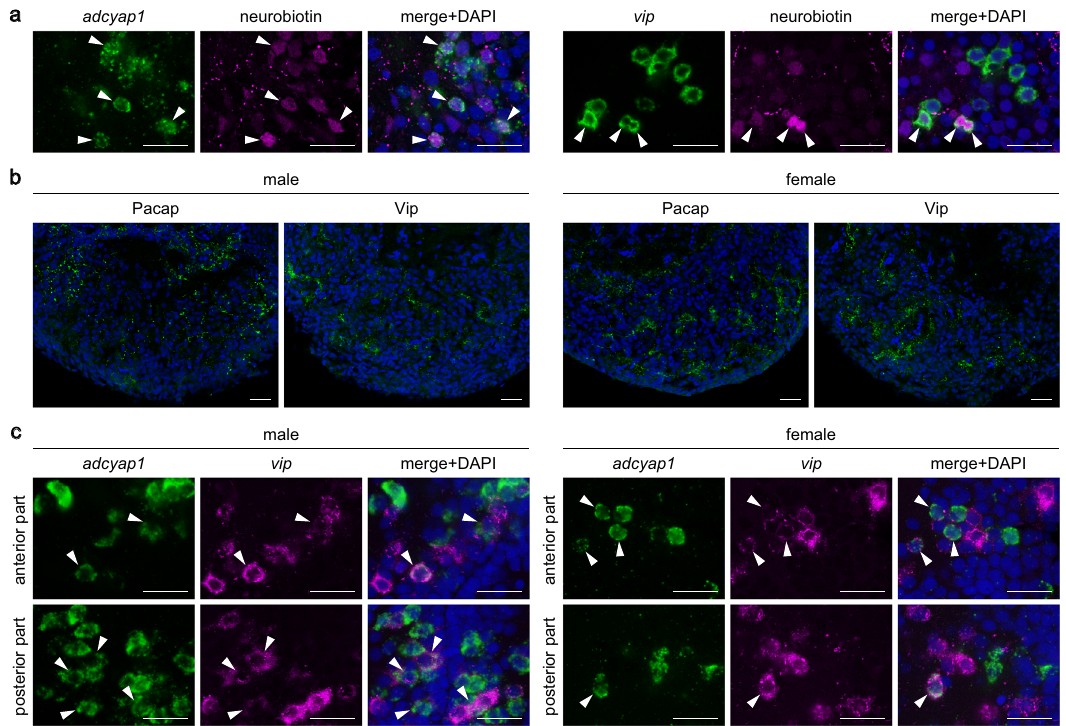
Fig. 6 adcyap1 and vip are expressed in the same population of POA neurons that project to the pituitary. a Retrograde labeling of adcyap1 - and vip - expressing neurons in the PMp after injection of the neuronal tracer Neurobiotin into the anterior pituitary. Left and middle panels show images of, respectively, adcyap1 / vip expression (green) and Neurobiotin labeling (magenta) in the same section; right panel shows the merged image with nuclear counterstaining (blue). Arrowheads indicate representative adcyap1 / vip -expressing neurons labeled with Neurobiotin. Representative images of adcyap1 - and vip -expressing neurons in a male and female, respectively, are presented. b Immunohistochemical detection of Pacap- and Vip-containing axons and varicosities (green) in the male and female anterior pituitary. Blue color indicates nuclear counterstaining. c Intermingled and partially overlapping distribution of adcyap1 - and vip -expressing neurons in the male and female PMp. Representative micrographs taken at two different levels along the anterior – posterior axis are shown. Left and middle panels show images of, respectively, adcyap1 (green) and vip (magenta) expression in the same section; right panel shows the merged image with nuclear counterstaining (blue). Arrowheads indicate representative neurons co-expressing adcyap1 and vip . Scale bars represent 20 μ